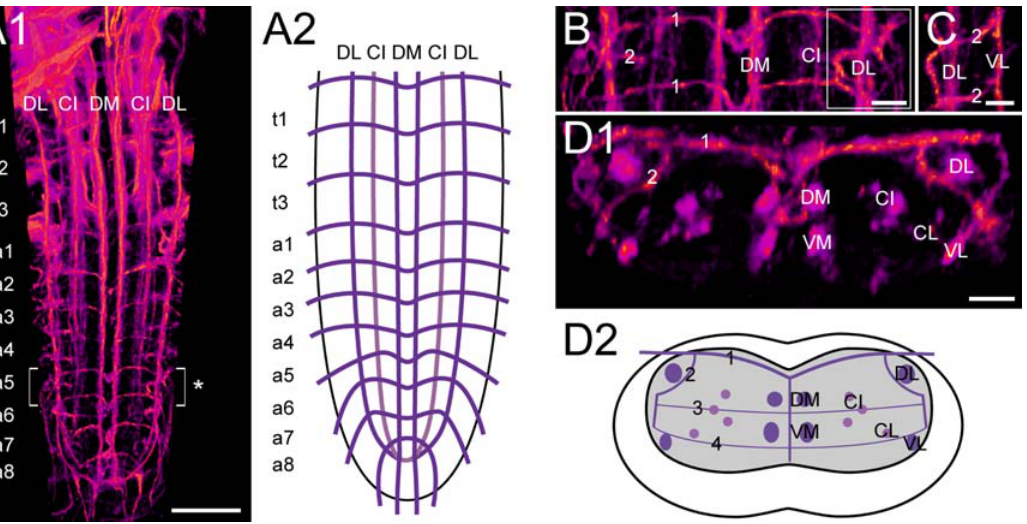
Figure 2. The Fasciclin2 landmark system in the Drosophila larval VG. A1) Dorsal view of a 3D image stack showing volume-rendered Fas2- immunoreactive tracts in the thoracic (t1-3) and abdominal neuromeres (a1-8) of the L3 larval VG, and A2) the deduced idealized dorsal scheme. B) Detailed dorsal and C) lateral view of a5 and adjacent neuromeres (* in A1). D1) Transversal view of a5, and D2) the deduced idealized transversal scheme. Longitudinal projections are named according to their relative dorso-ventral (D: dorsal, C: central, V: ventral) and medio-lateral (M: medial, I: intermedial, L: lateral) position. For example, the two dorso-medial Fas2-immunoreactive tracts are referred to as DM tracts. Transversal projections (TP) are numbered according to their relative dorso-ventral position, i.e. ‘‘1’’ represents the topmost TP [19]. Scale bars: 50 m m in A), 10 m m in B), C), and D).